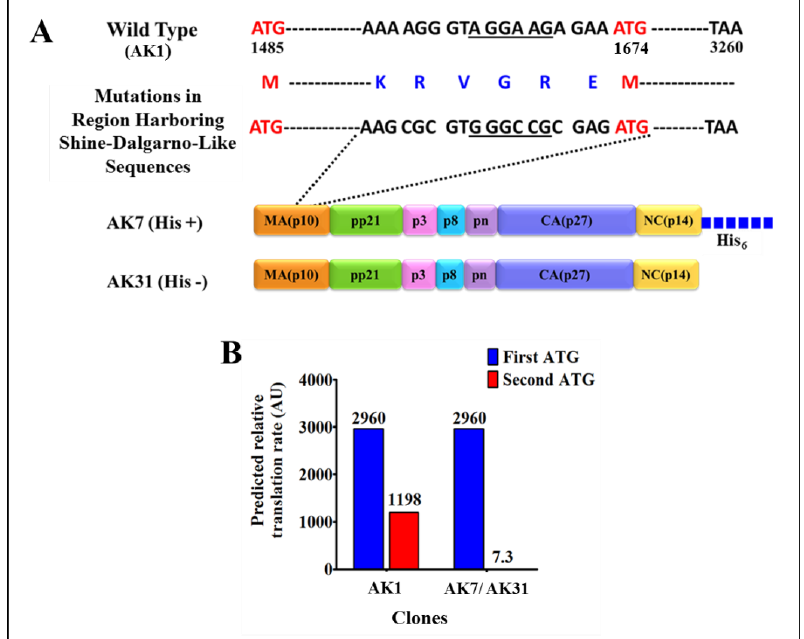
Figure 4. Silent mutations in the Shine-Dalgarno-like sequence and the predicted relative translation rates from the first and the second in-frame ATGs. ( A ) Illustration of the 18-nucleotide region mutated in MMTV gag gene to disrupt the Shine-Dalgarno-like sequence (underlined) 4 nts upstream of the second in-frame ATG (at nucleotide position 1674). These mutated sequences were cloned in both with and without His-tag clones AK7 and AK31, respectively; ( B ) Bar graphs showing the predicted translation rates from the legitimate first start codon and the second in-frame start codon in the wild type and in AK7(His+) and AK31(His − )-containing a mutated Shine-Dalgarno-like sequence.